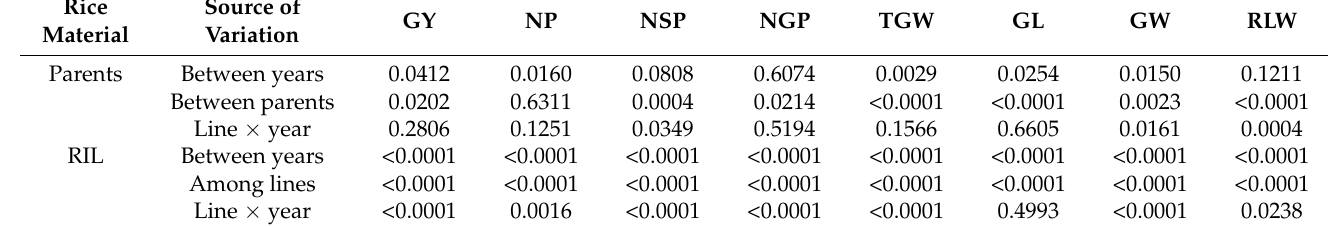
showed significant line × year interaction. These results showed that the variation of these traits was influenced by different environments. Table 2. Two-way ANOVA of phenotypic performance of the parents and RIL population.